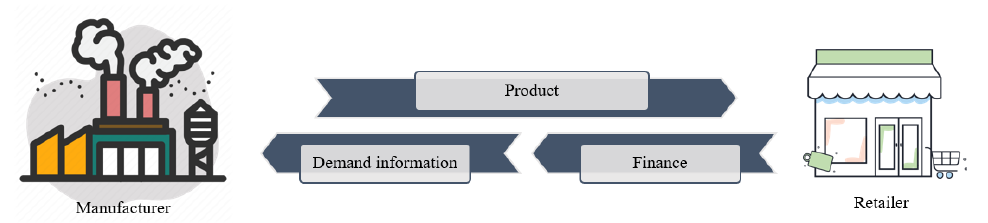
Figure 1. Traditional